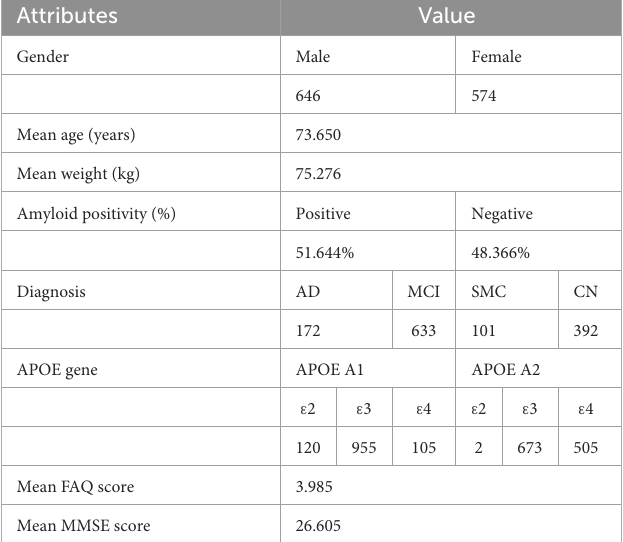
TABLE 1 ADNI subject information. All statistics were created from the set of unique patients (n = 1,298). Some attributes were missing from